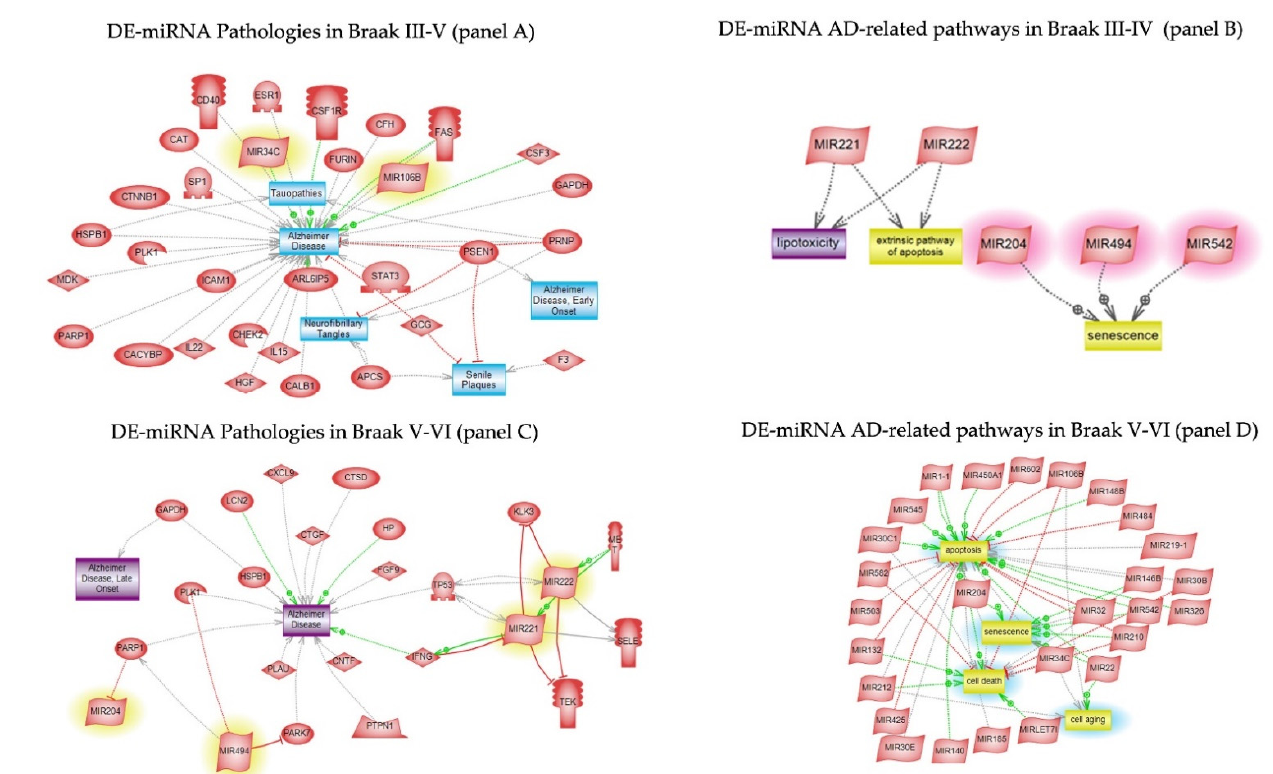
Figure 5. DE-miRNA pathway studio analyses in Braak III-IV and Braak V-VI. The pathological processes triggered by Braak III-IV DE-miRNA (panel A) and Braak V-VI DE-miRNA (panel C). The related pathways of Braak III-IV DE-miRNA (panel B) and Braak V-VI DE-miRNA (panel D). DE-proteins pathways are represented in Figure 6 and confirmed the ECM and cell- cell adhesion among the main processes regulated during AD development.